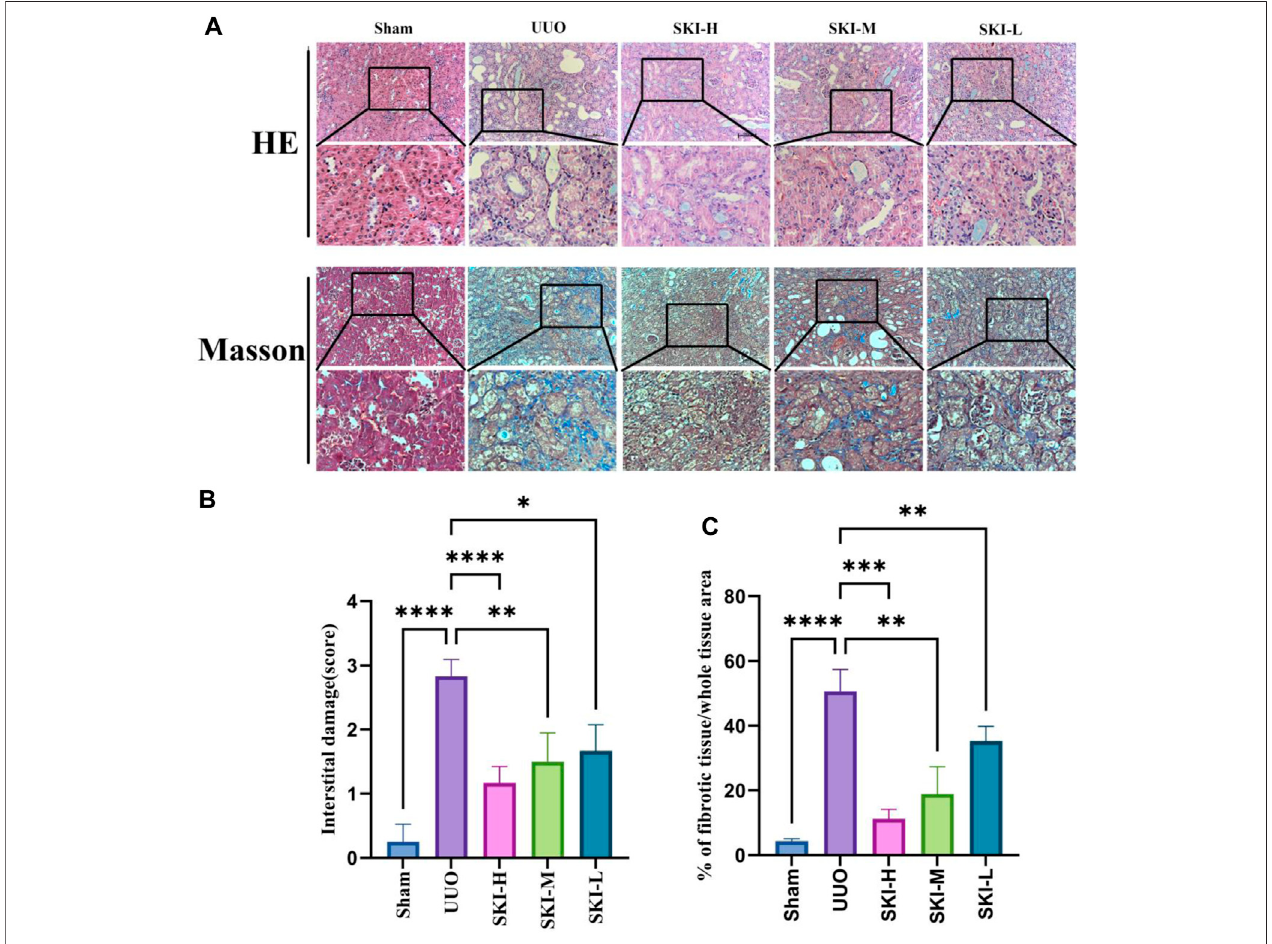
FIGURE 3 | Effect of Shenkang injection on kidney histological changes and collagen deposition in UUO mice (200X). (A) HE staining and Masson staining in different groups, original magni fi cation: ×200. (B and C) The degree of tubulointerstitial injury and tubulointerstitial collagen deposition were evaluated semi- quantitatively. Data are shown as mean ± SD. * p < 0.05, ** p < 0.01, *** p < 0.001, and **** p < 0.0001.